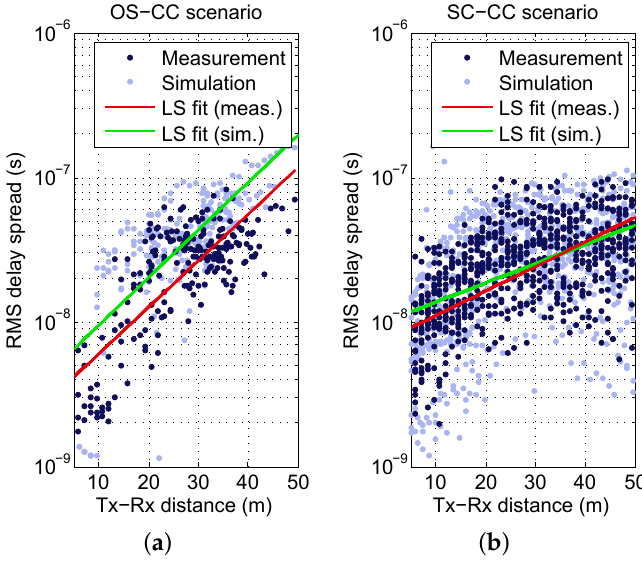
Figure 6. Measured and simulated DS as a function of distance with linear least-squares (LS) fit: ( a ) OS-CC scenario; ( b ) SC-CC